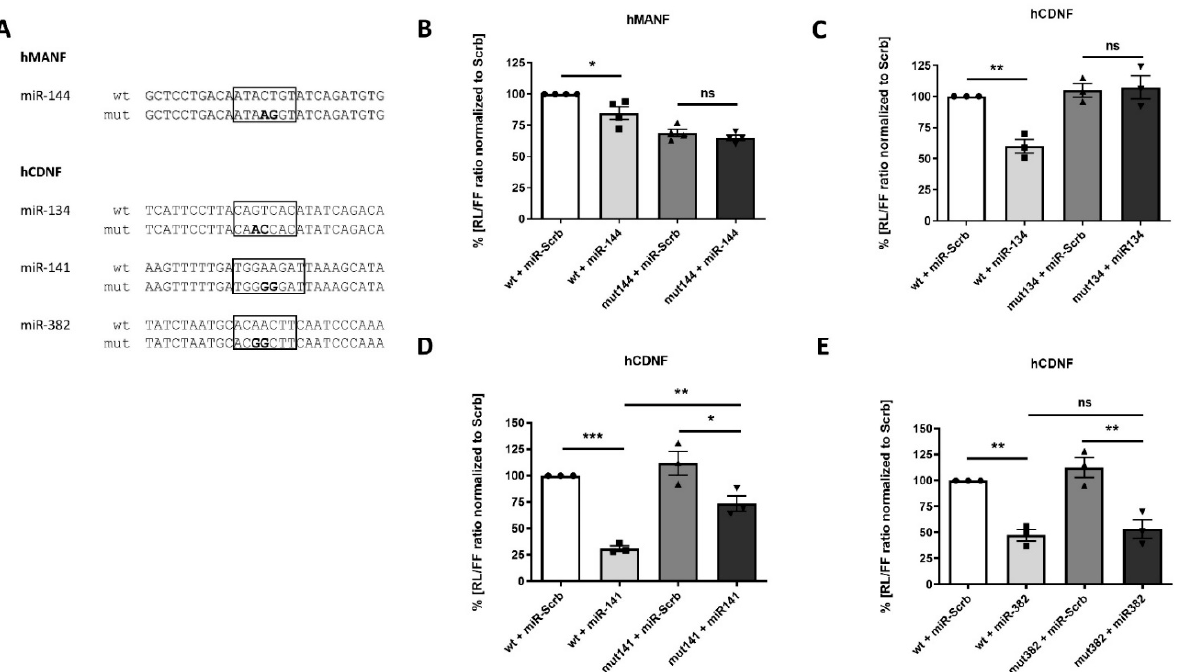
Figure 5. Regulation of luciferase activity via miRNA predicted binding sites. ( A ) Sequences of predicted miRNA binding sites: wild-type (wt) and mutated (mut). Predicted seed regions are framed. Mutations within binding sites of ( B ) miR-144, ( C ) miR-134, partially ( D ) miR-141, but not ( E ) miR-382, ablated ability of corresponding miRNAs to regulate luciferase signal. Each dot represents mean value from one plate with 4 wells per group. *— p -value < 0.05, **— p -value < 0.01, ***— p -value < 0.001.